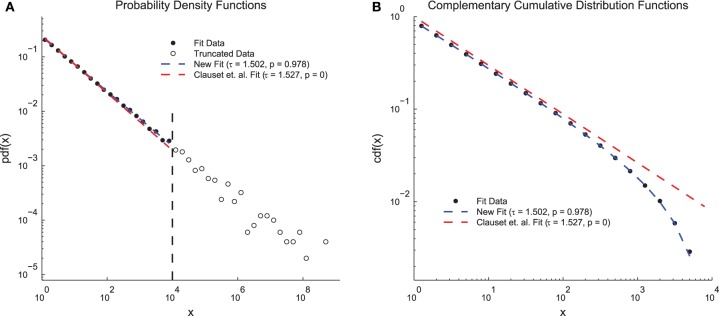
Clauset et. al. power-law fit method comparison. (A) Probability density functions for truncated simple model data, a fit using the methods introduced herein, and a fit using previous methods (Clauset et al., 2009). Both methods produce fits that qualitatively match the data and that have exponents near the true value of τ = 1.5. However, the previous methods produce a low p-value (reject power-law hypothesis) and the new methods produce a high p-value (accept power-law hypothesis). (B) Complementary cumulative distribution functions for the fit data from (A). The CDF of the model data appears bent due to the truncation. The new methods introduced herein are able to account for this distortion and still fit the data. The previous methods produce a low p-value because they assume the CDF will still be a power law.